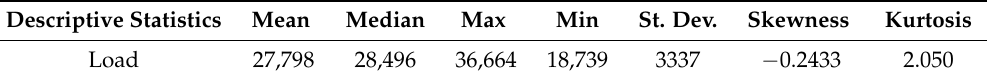
Table 1. Summary statistics for hourly electricity demand (MW). Descriptive Statistics Mean